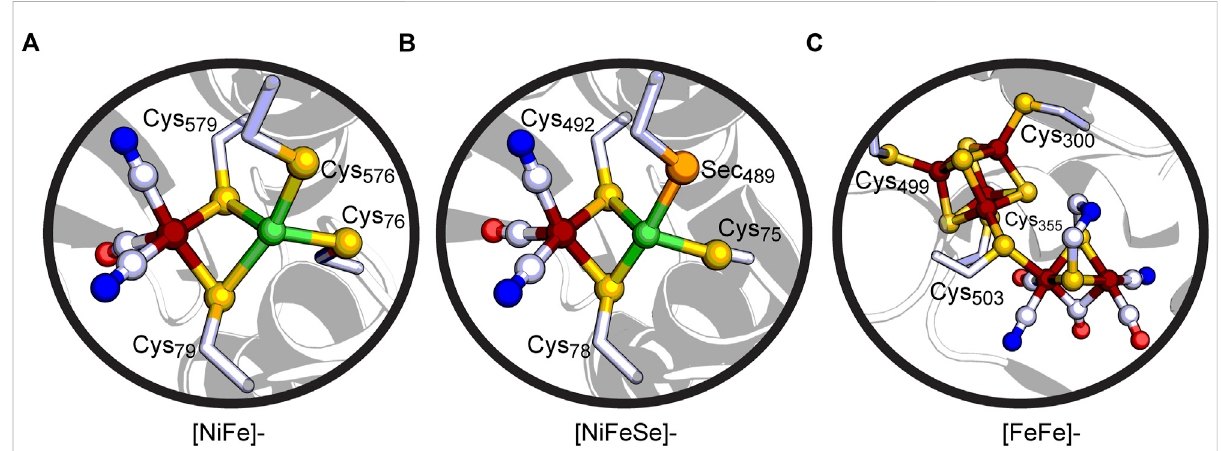
FIGURE 2 Cut-away views of (A) the active site of the [NiFe]-hydrogenase Hyd-1 from Escherichia coli (PDB: 5A4M), (B) the active site of the [NiFeSe]- hydrogenase from Desulfovibrio vulgaris Hildenborough (PDB: 5JSK), and (C) the H-cluster active site of the [FeFe]-hydrogenase CpI from Clostridium pasteurianum (PDB: 3C8Y). Coloring scheme: C, white; O, red; N, blue; S, yellow-orange; Se, orange; Ni, green; Fe,